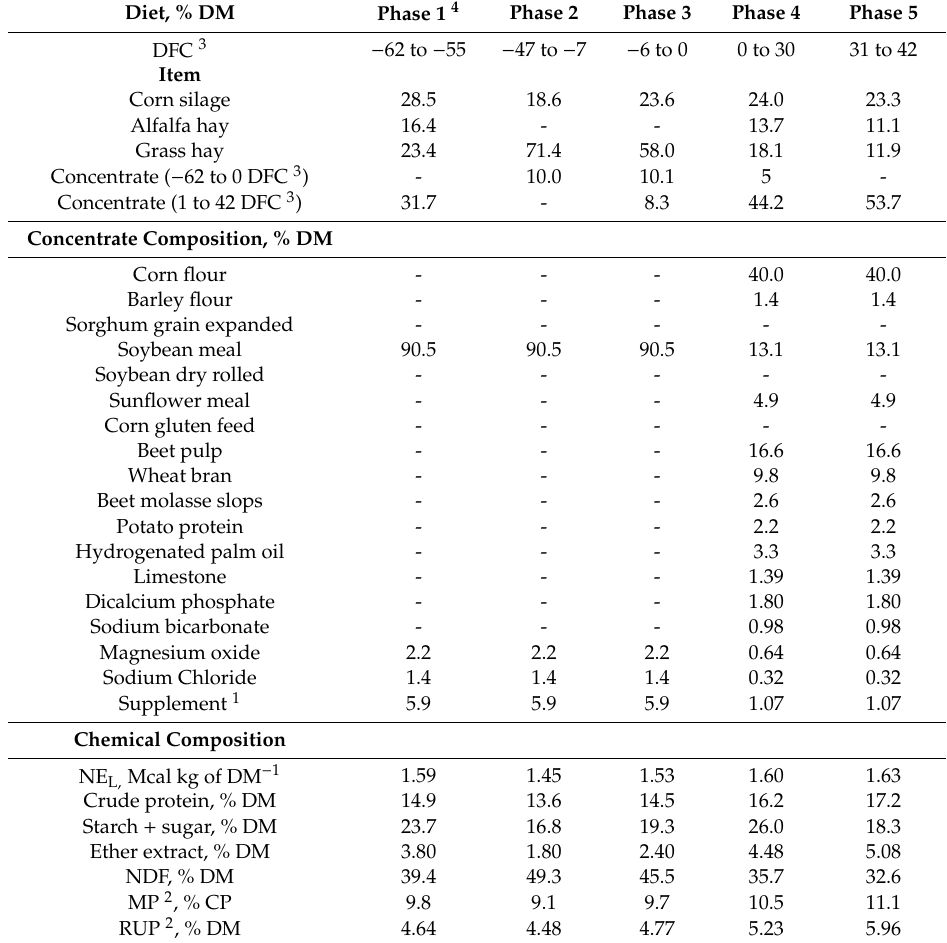
Table 1. Composition and characteristics of the experimental diets fed to cows during the 5 experimental